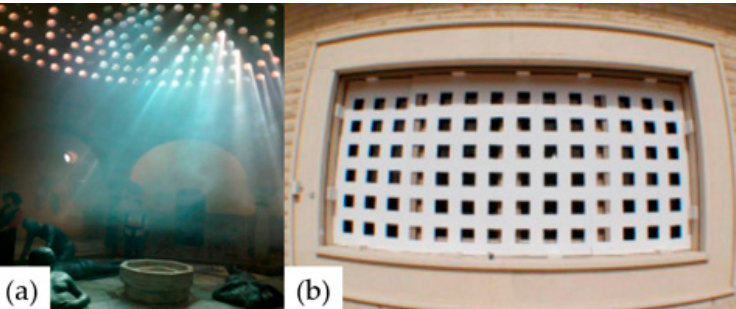
Figure 1. ( a ) Hammam al Bacha in Acre (18th Century Ottoman era); ( b ) Fisheye photography of the